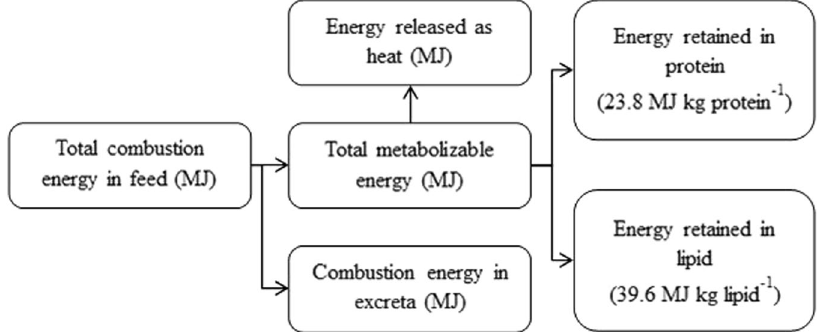
Figure 5. The components of energy flow through a broiler